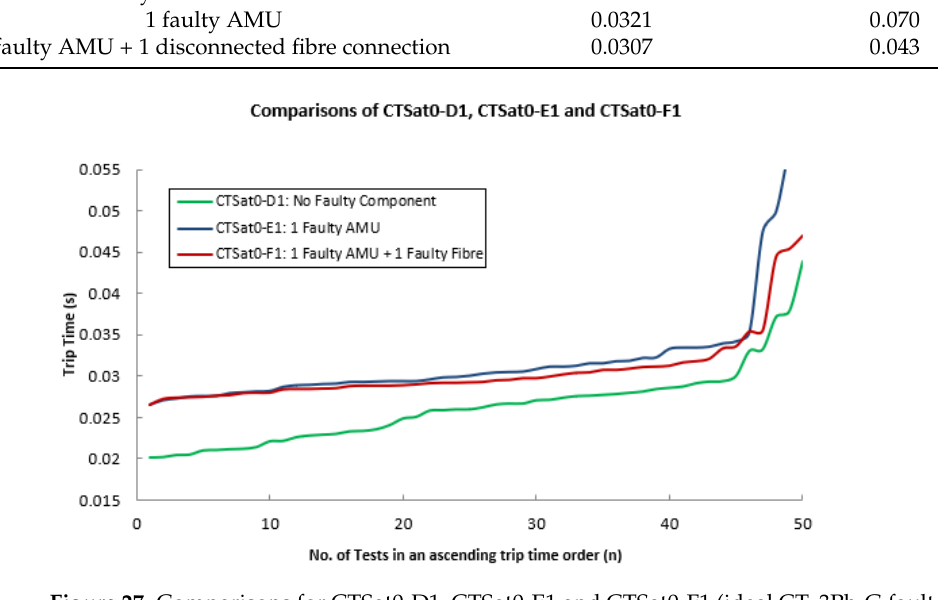
Figure 27. Comparisons for CTSat0-D1, CTSat0-E1 and CTSat0-F1 (ideal CT, 3Ph-G fault at 50% of the feeder).